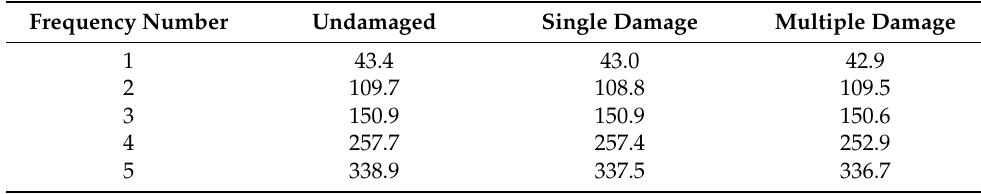
Figure 2. Numerical model of the 27-bar truss structure. Table 1. Natural frequencies without noise for the undamaged and damaged structures (unit: Hz).